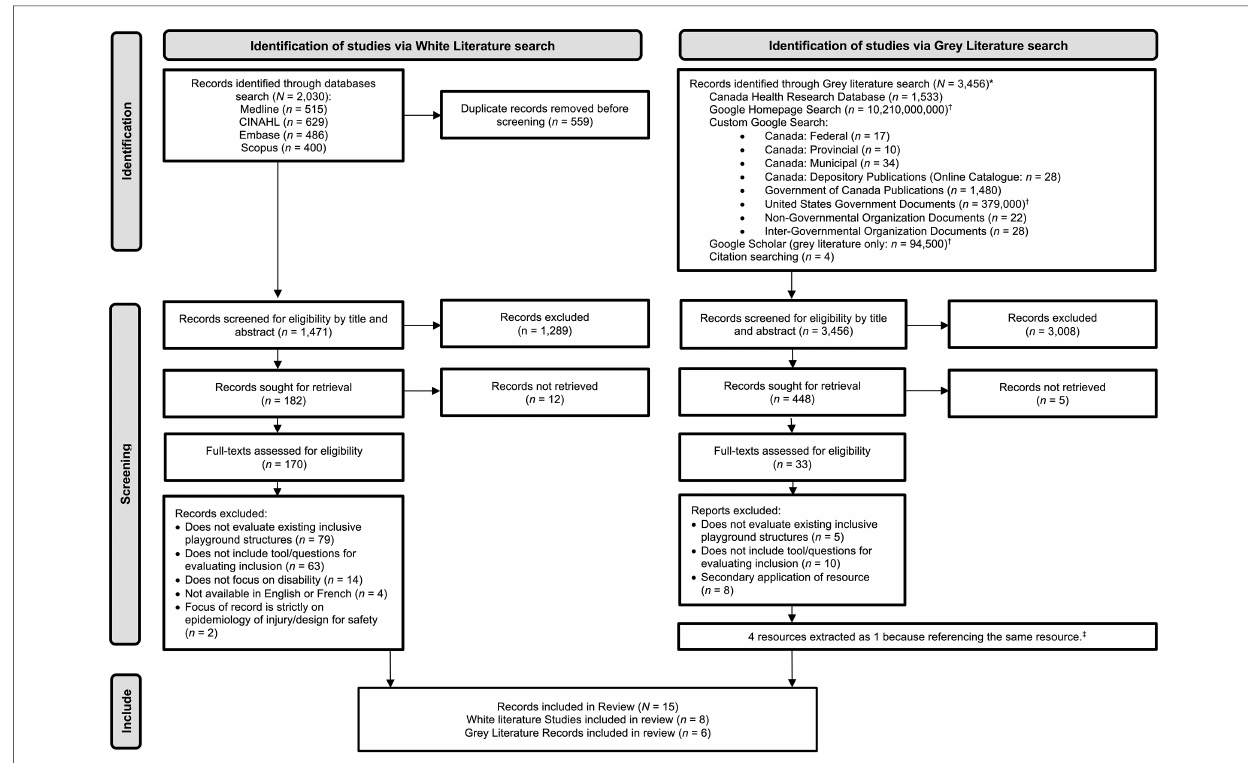
FIGURE 1 PRISMA fl ow diagram. *Number indicates search where fi rst 10 pages (i.e., 100 results) were reviewed if results were considered in fi nite, to capture many of the most relevant hits while still being a feasible amount to screen (Godin et al., 2015). † Searches using fi rst 10 pages of search results